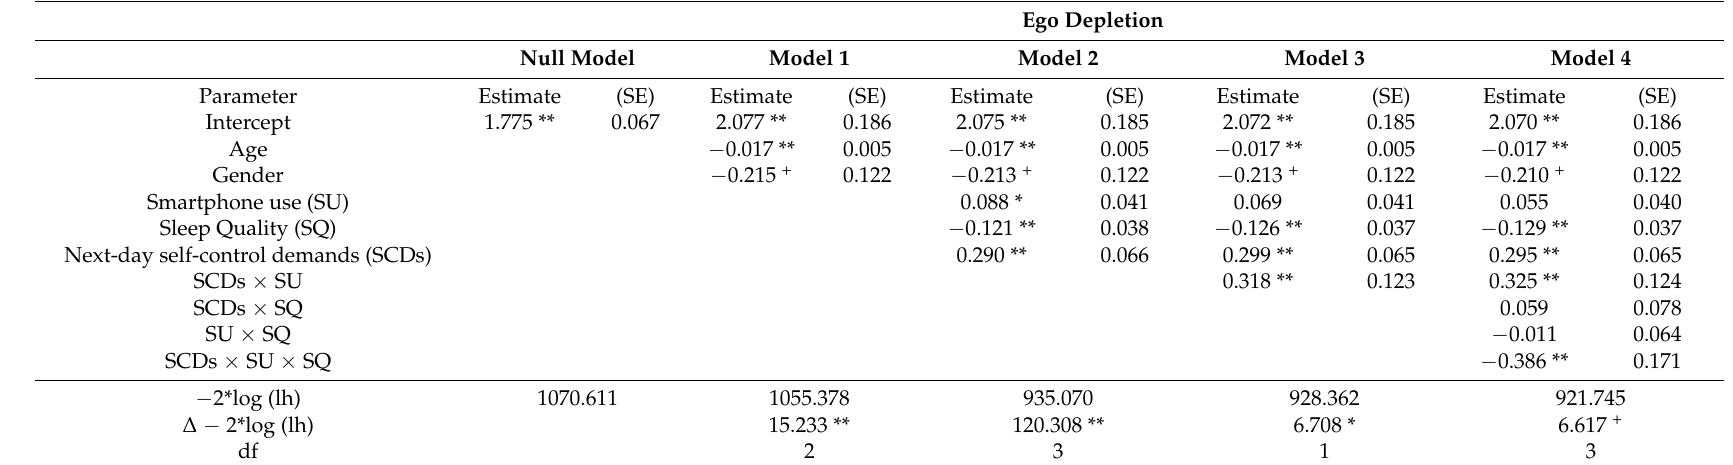
Table 2. Multilevel estimates for predicting next-day ego depletion at